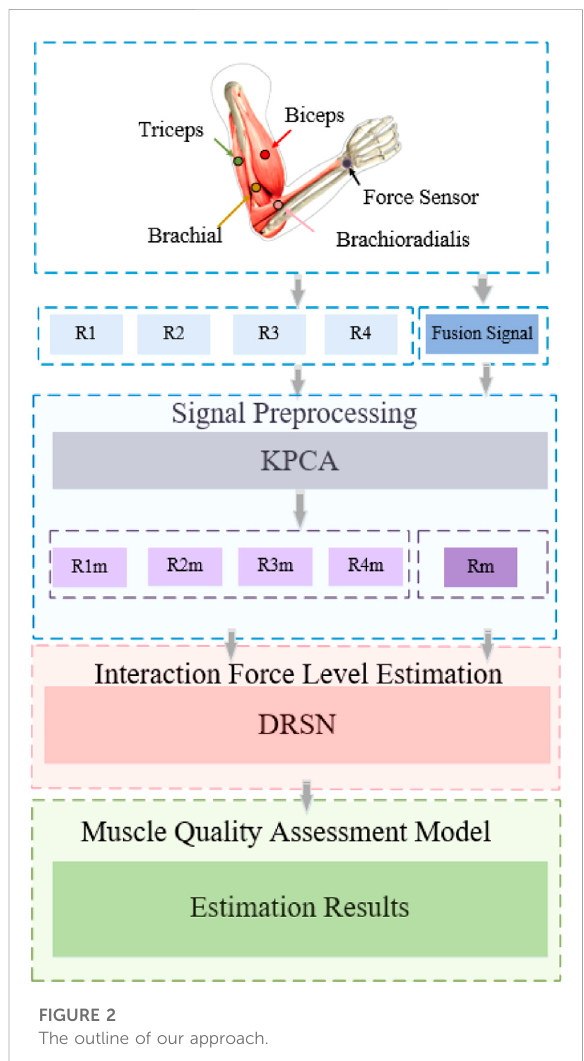
FIGURE 2 The outline of our